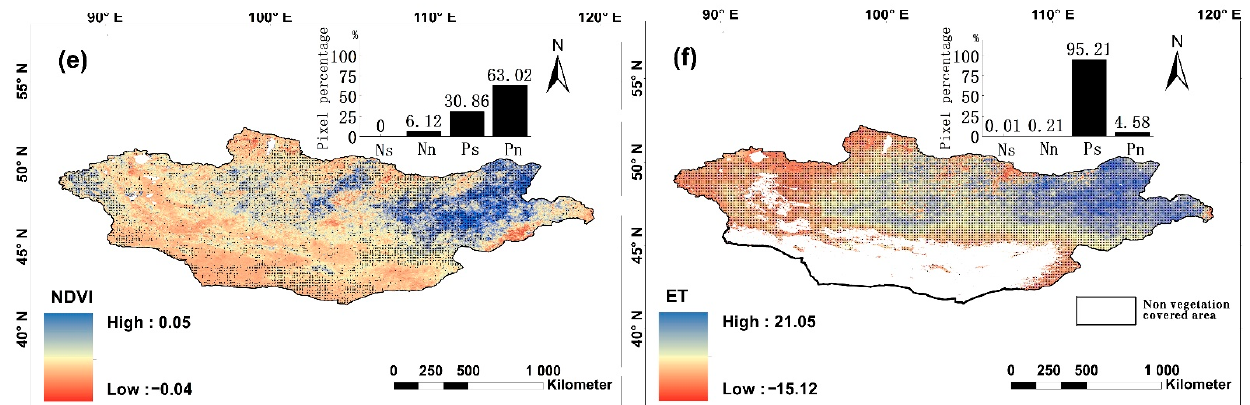
Figure 2. Spatial trends of the annual average values of ET and natural factors in Mongolia from 2001 to 2020. Black dots indicate significant changes ( p < 0.05). The inset histograms display the